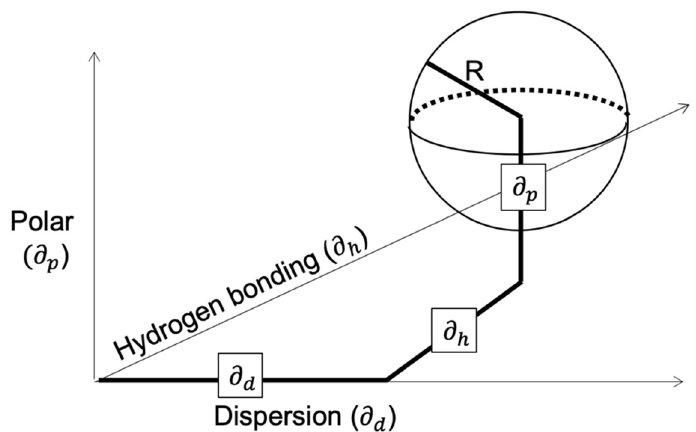
Figure 1. Representation of the Hansen 3D model of a solubility sphere with radius R, as determined by the polar, dispersion, and hydrogen bonding components, respectively.